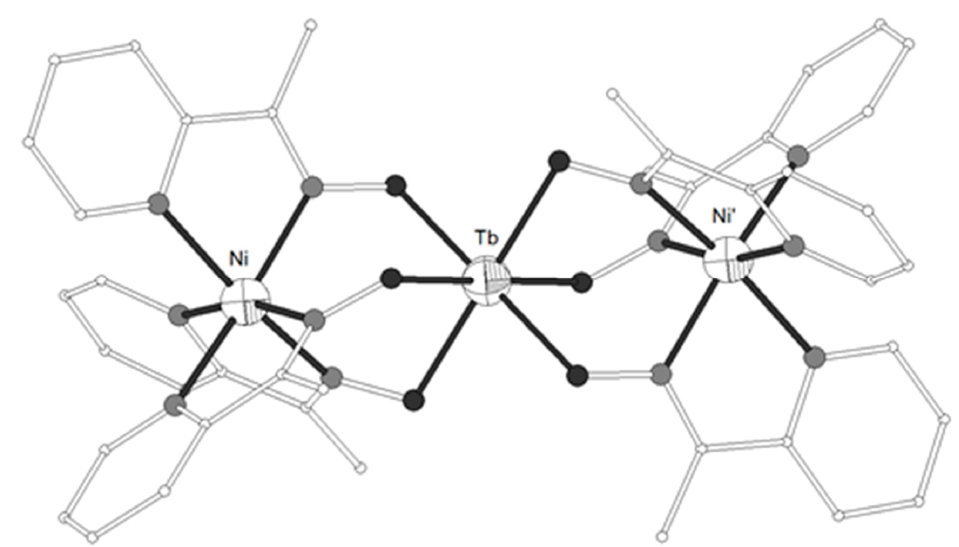
Figure 14. The molecular structure of the cation complex [{Ni(L 27 ) 3 } 2 Tb] + 139 . Primed atoms are generated by symmetry: (‘) – x + y , − x , z . Color code: Tb large octant, Ni small octant, N light grey, O dark grey, C open small, S open large [11].